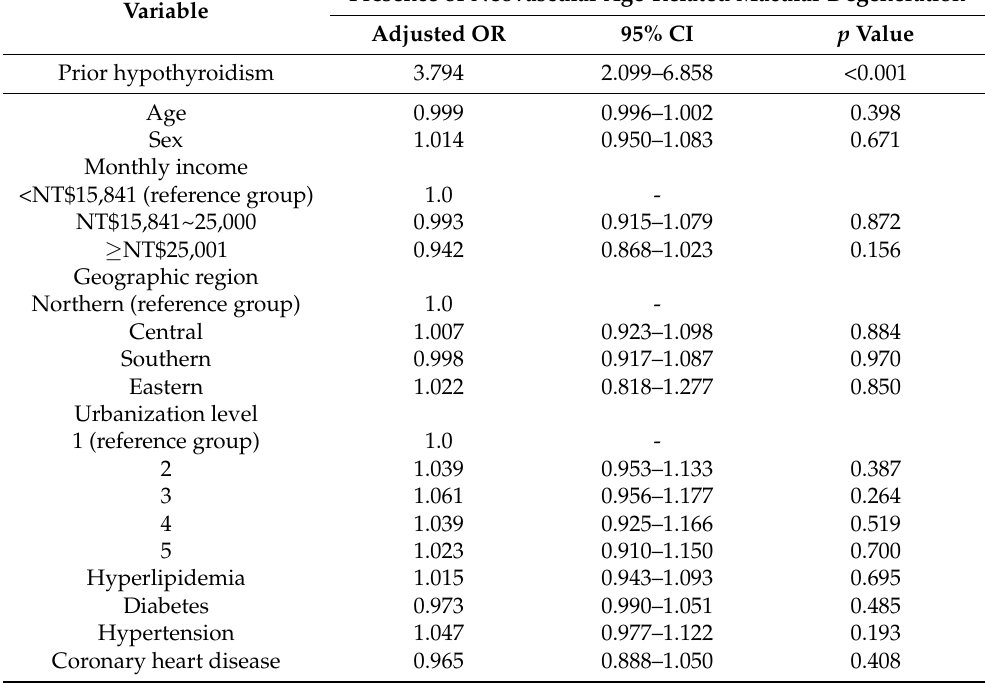
Table 4. Covariate-adjusted odds of prior hypothyroidism (OR and 95% confidence interval, CIs) among neovascular age-related macular degeneration vs. controls ( n =